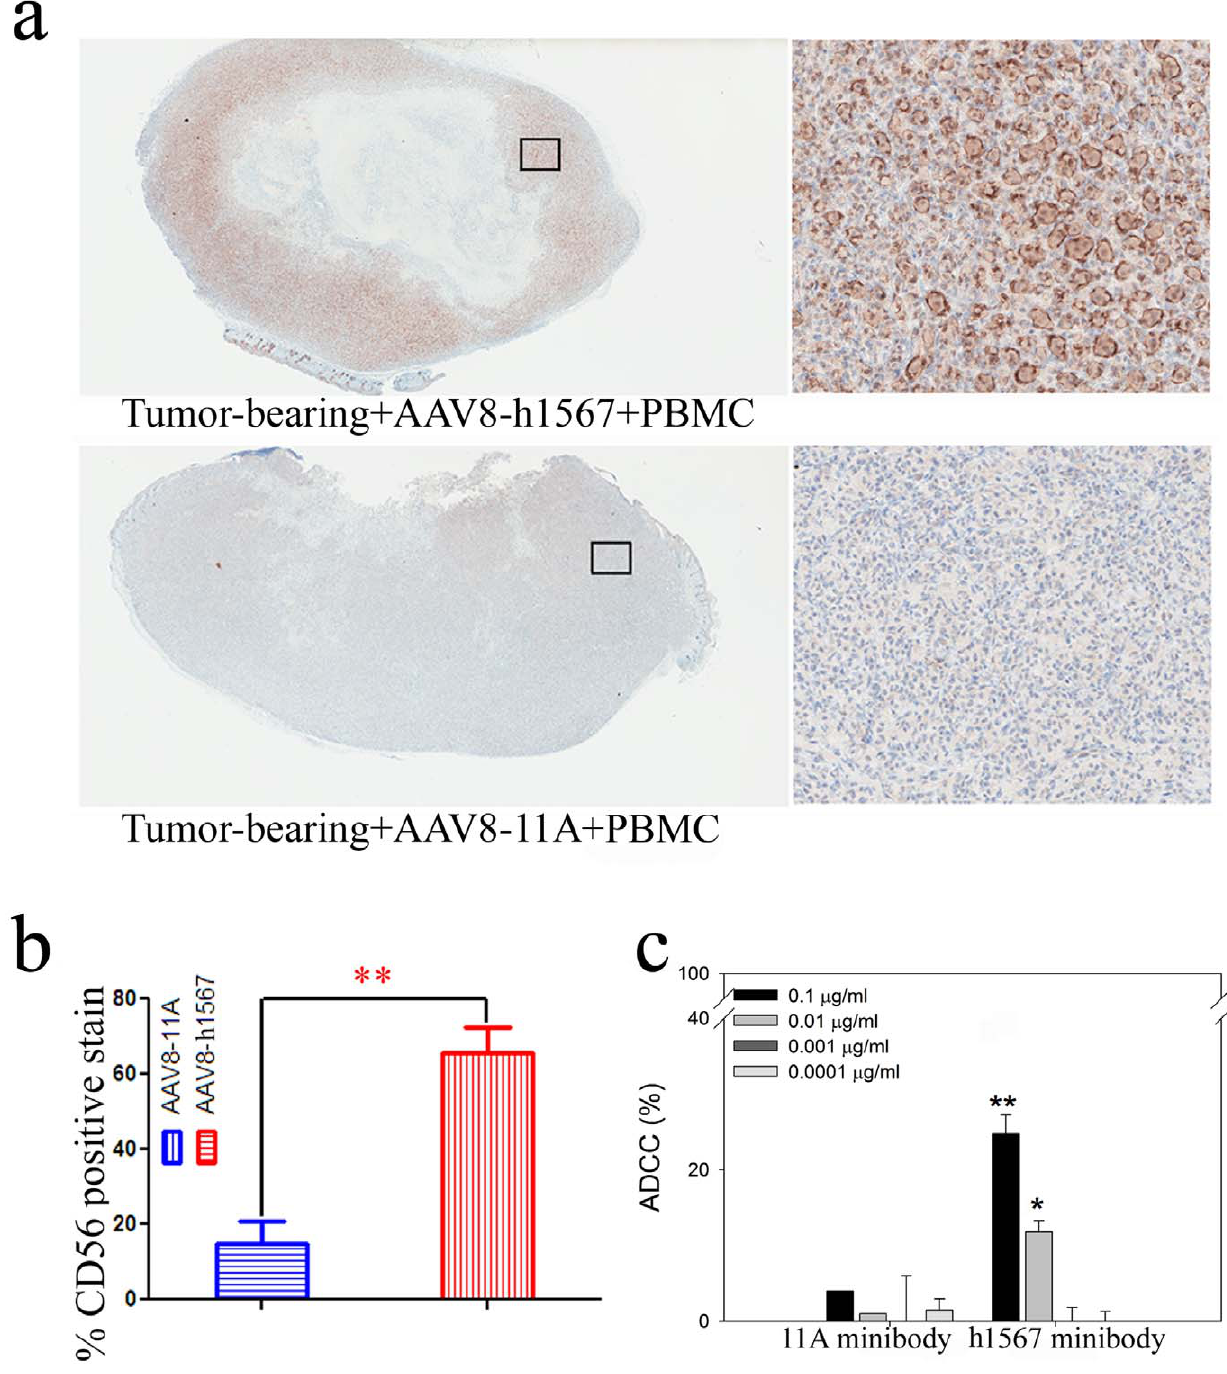
Figure 4. ADCC activity of h1567 minibody in a xenograft human PBMC-SCID/BEIGE mouse model. ( a ) Immunohistochemical staining of a representative tumor section with mAb directed against human NK cell surface marker CD56. The immunostaining shows highly positive CD56 tumor-infiltrating human NK cells (brown stain) in tumor from the SCID/BEIGE mice treated with AAV8-h1567 and hPBMCs (upper panel). Negative CD56 staining was seen in the tumor treated with control vector AAV8-11A plus hPBMCs (lower panel). Images are shown from whole tumor cut sections (left panels) and tumor sections at 20 6 magnifications (right panels). ( b ) The percentage of immunohistochemically detected tumor- infiltrating natural killer cells was plotted. A significantly higher percentage of tumor-infiltrating human CD56-positive cells were detected in the AAV8-h1567-treated mice group. **, p , 0.01. ( c ) NK cell-mediated cytotoxicity was observed in a dose-dependent manner. Minibody concentrations from 0.0001 to 0.1 ug/ml were tested at an E:T ratio of 2:1. The average and error bars (mean + SD) shown were calculated from triplicate wells of one experiment. The figures shown are representative of three independent experiments. *P , 0.05, **P , 0.01 when comparing h1567 minibody-treated and 11A control minibody-treated group. All data is shown as the mean 6 SD.